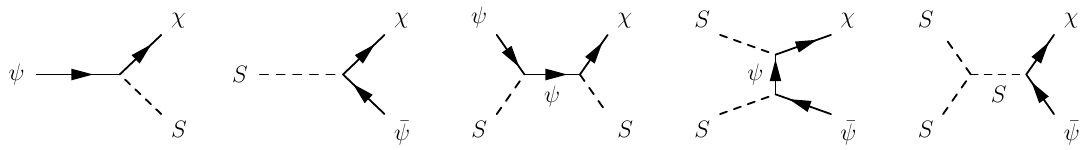
Figure 1 . Dark matter freeze-in reactions in the toy model of kinematically induced freeze-in, see eq. (2.1). For